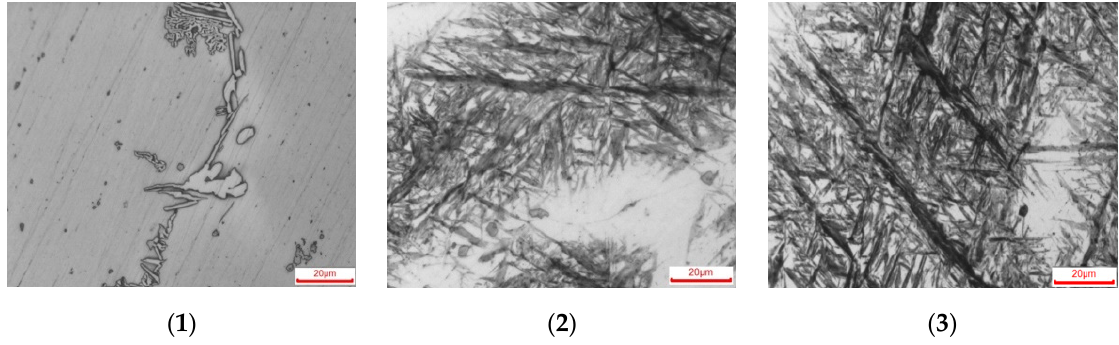
Figure 8. Matrix microstructure, ( 1 ) High manganese steel, ( 2 ) Medium chromium alloy steel, ( 3 ) High chromium alloy steel.